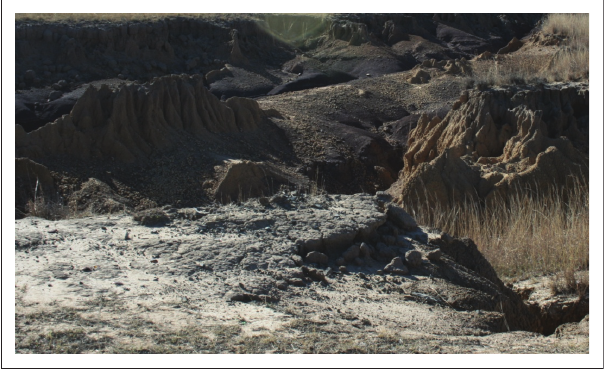
FIGURE 6: Severely degraded land in Mfolozi village near Tsolo. Source : Photo taken by Andries Jordaan.